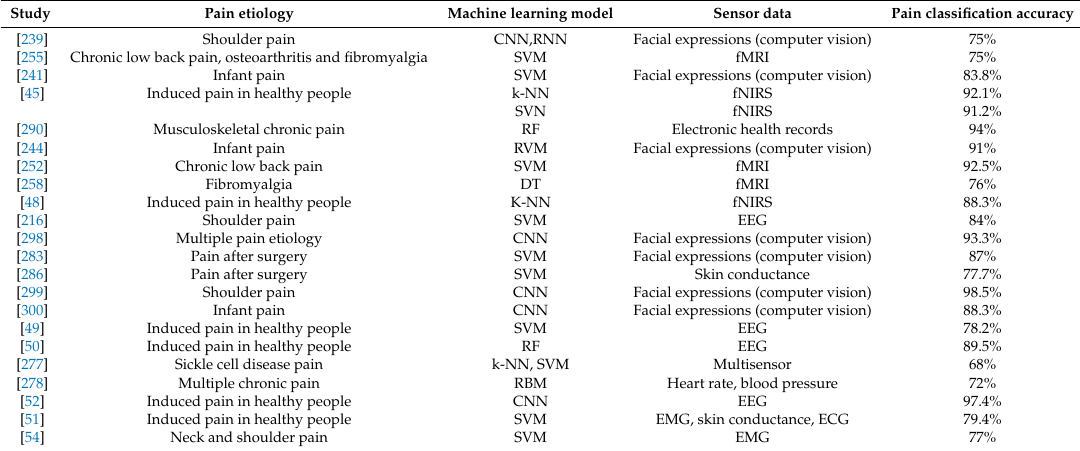
Table 1. Processing algorithms examples for pain